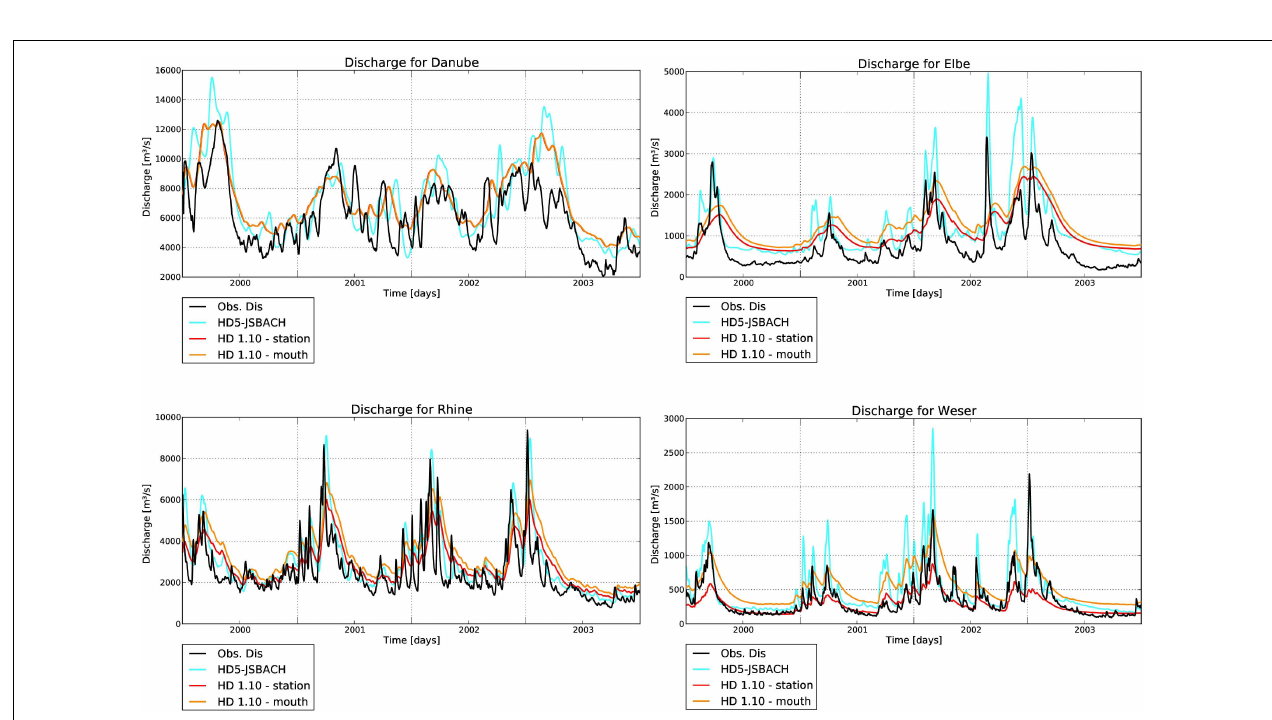
FIGURE 6 | Simulated and observed daily discharges for selected rivers from 2000–2003. Simulated discharges comprise HD5-JSBACH and HD 1.10 simulations at 0.5 ◦ whereat for the latter, discharges close to the discharge gauge and the river mouth are provided. Note that for the Danube, the station is close to the river mouth so that the related discharges are almost